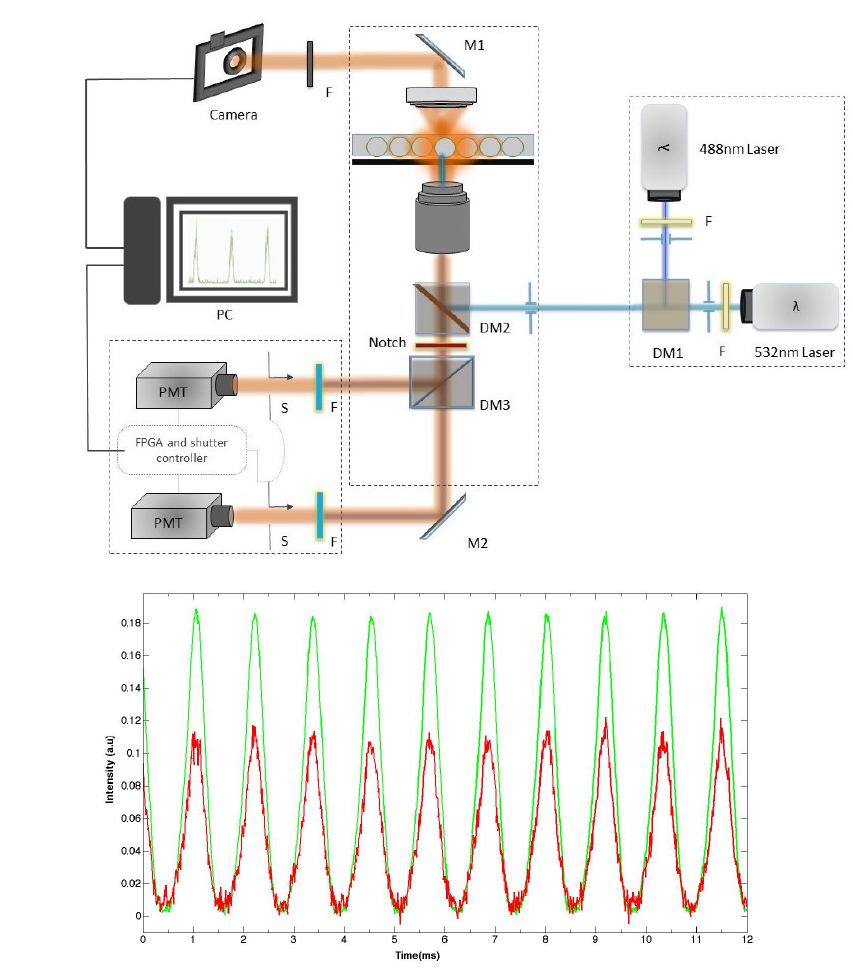
Figure 2. ( top ) A typical dual channel microfluidic droplet monitoring setup, consisting of two laser sources with each laser band limited by a bandpass filter. The two components of the fluorescence signals emitted by the two different dyes are separated, filtered, and collected on two different photo-multiplier tubes (PMTs). ( bottom ) Typical recorded fluorescence intensity versus time emitted by flowing droplets containing both fluorescein and rhodamine dyes at different concentrations. DM: dichroic